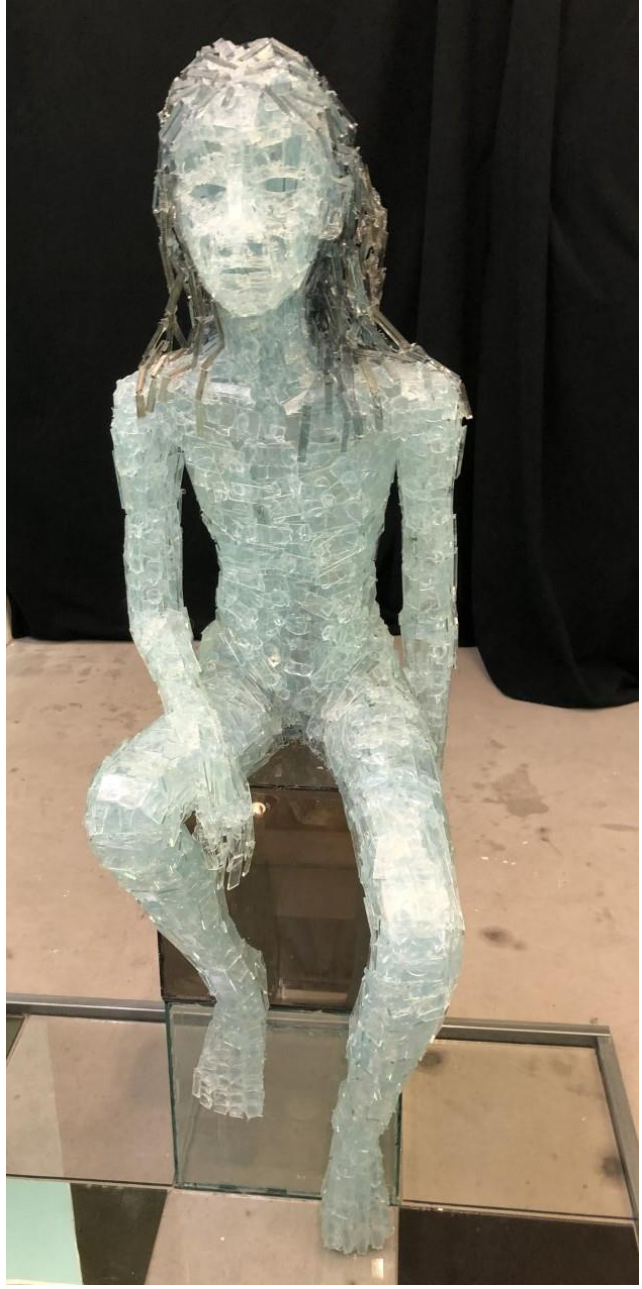
Figure 3. Alina Rom Cohen, 1700 km, 2019 (Detail)